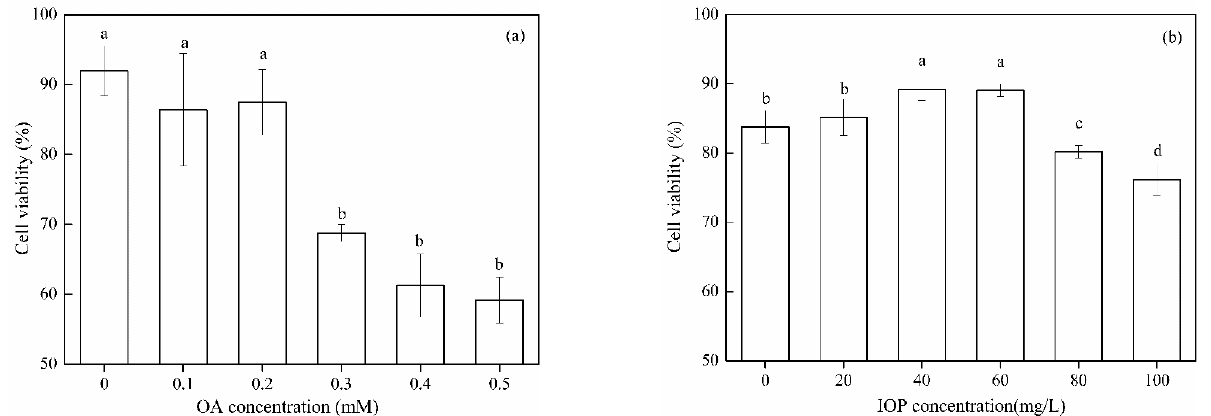
Figure 2. Cell viability of HepG2 cells. ( a ) Effect of OA on the cell viability of HepG2 cells. ( b ) Effect of IOP on the cell viability of OA-induced HepG2 cells. Each value represents the mean of six replicates, and error bars indicate standard deviation ( ± SD). Different letters show the significant difference between different groups of cells ( p < 0.05).